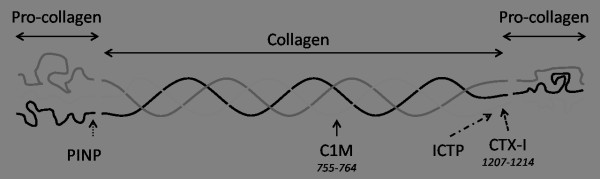
Biochemical markers of type I collagen. PINP, Pro-collagen type I N-terminal pro-peptide; C1M, MMP-degraded type I collagen. The C1M peptide is located at amino acid position 755 to 764 in the mature collagen strands. ICTP, Pyridinoline cross-linked carboxyterminal telopeptide of type I collagen. CTX-I, cross-linked c-telo-peptide of type I collagen at amino acid position 1207 to 1214.